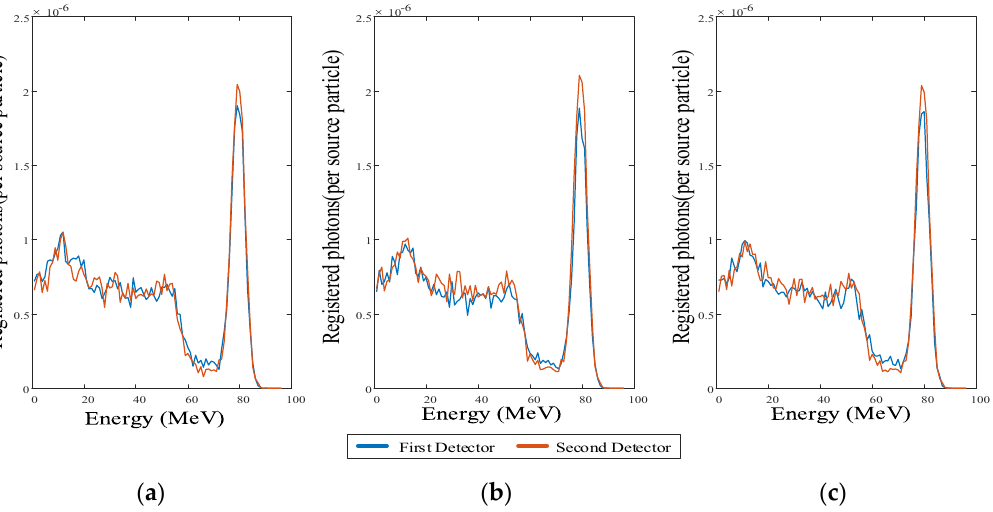
Figure 5. The registered photon energy spectra in the first and second detectors (void fraction = 5%): ( a ) annular, ( b ) homogenous, and ( c ) stratified.